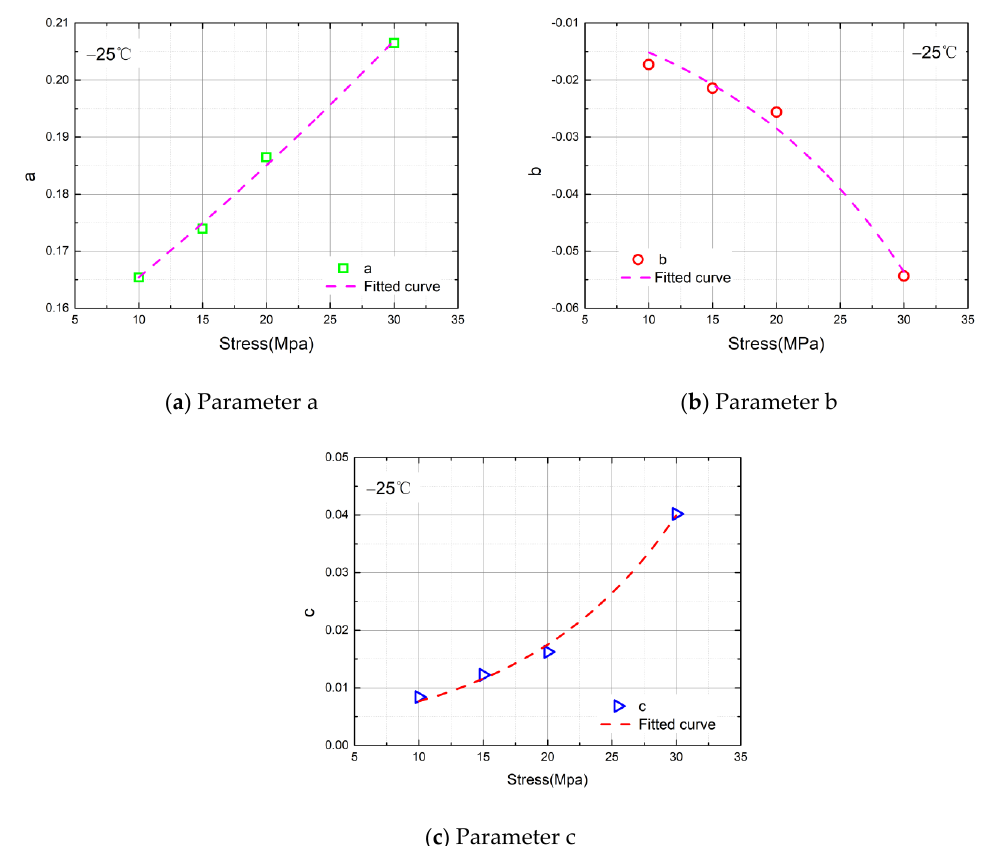
Figure 11. ( a ) Fitted curve of the value of parameter a when T = − 25 °C. ( b ) Fitted curve of the value of parameter b when T = − 25 °C. ( c ) Fitted curve of the value of parameter c when T = − 25 °C.